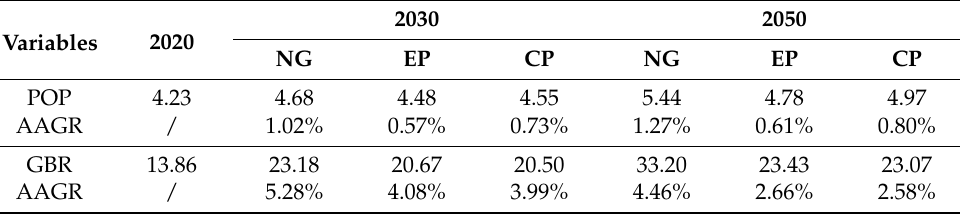
Figure 6. Spatial distribution of future runoff coefficient (RC) in 2030 and 2050. NG, EP, and CP scenarios represent natural growth, ecological protection, and cropland protection scenarios, respectively. Subfigures ( a ), ( b ) and ( c ) are the RCs under NG, EP and CP scenarios in 2050, respectively. Subfigures ( d ), ( e ) and ( f ) are the RCs under NG, EP and CP scenarios in 2030, respectively. Subfigures g is the RC in 2020. Table 4. The total POP and GBR in the Jinjiang Basin under the three scenarios from 2020 to 2050. AAGR represents the average annual growth rate starting in